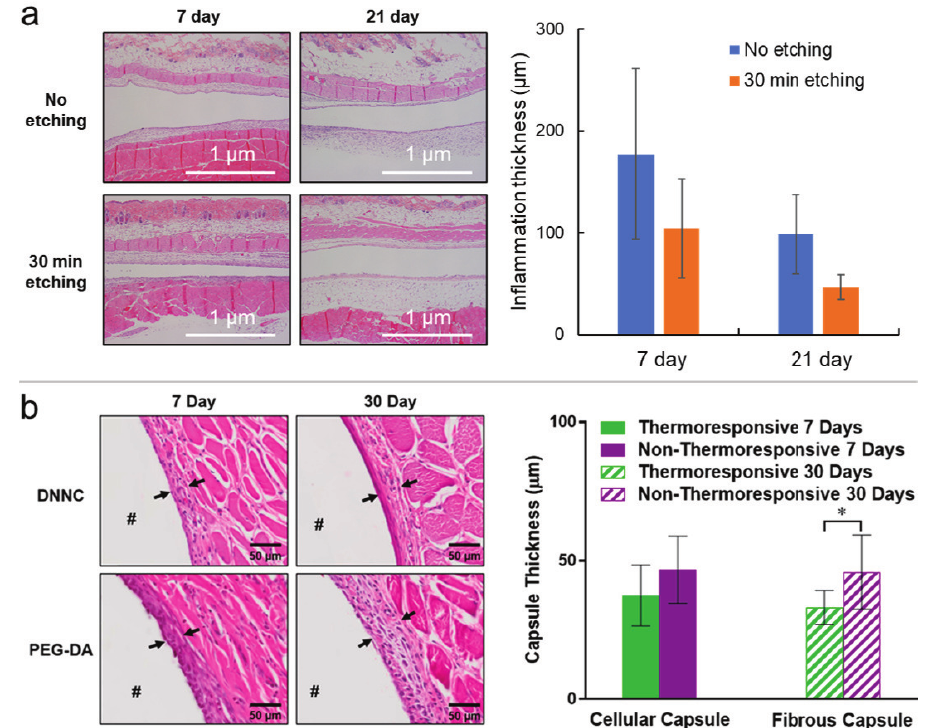
Figure 4. ( a ) Nanotextured polytetrafluoroethylene (PTFE) films after etching showed a thinner inflammatory band after 7 or 21 d of subcutaneous implantation. Adopted from [139]. ( b ) Implants made of temperature-responsive materials showed decreased fibrous capsulation thickness after 7 or 30 d of subcutaneous implantation. Adopted from